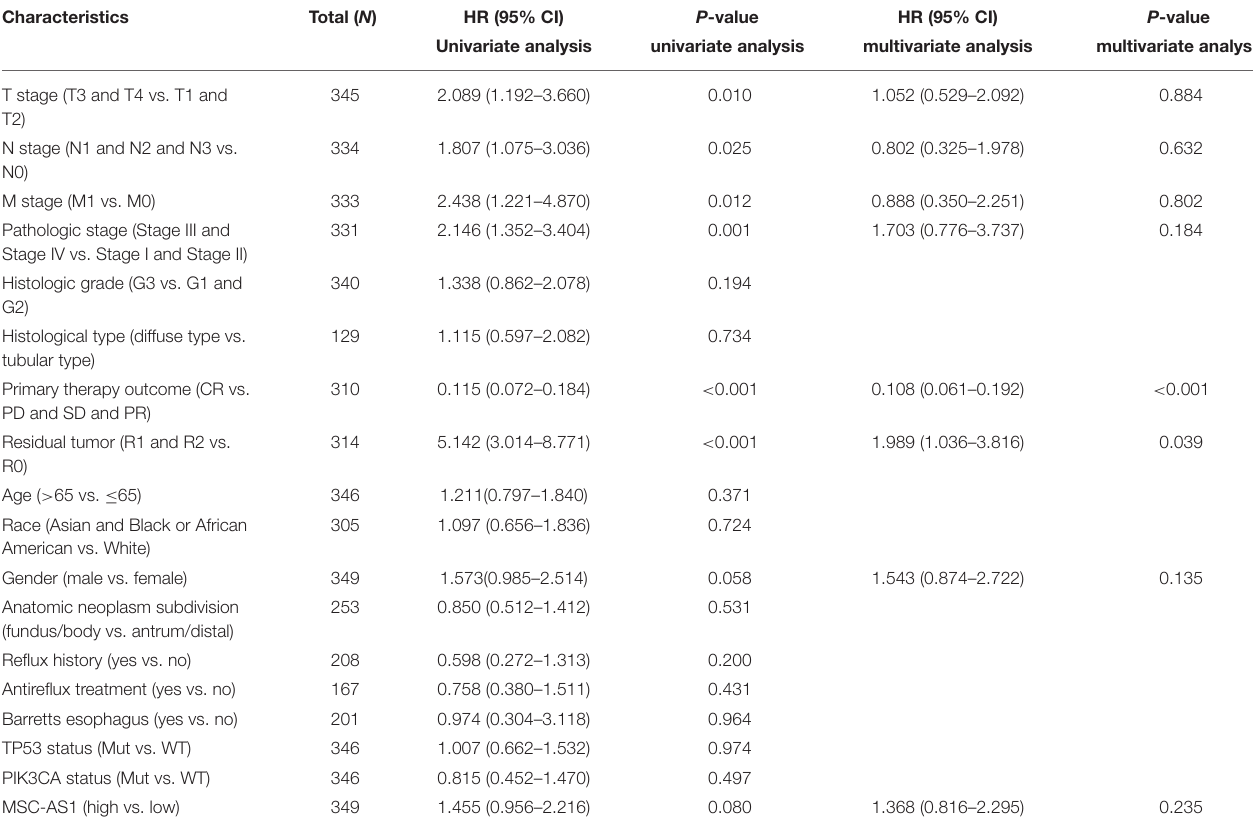
TABLE 4 | Associations between disease-specific survival and clinicopathological characteristics in patients in TCGA using Cox regression.